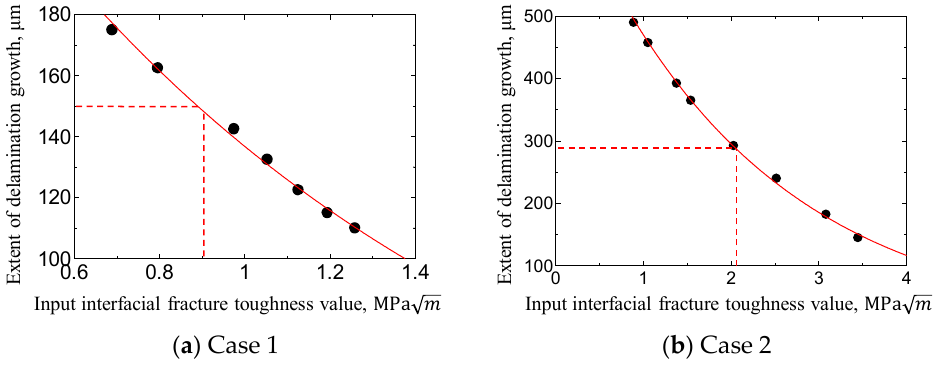
Figure 6. Relationships between the input interfacial fracture toughness value and the extent of delamination growth ( a ) Case1 and ( b ) Case 2.